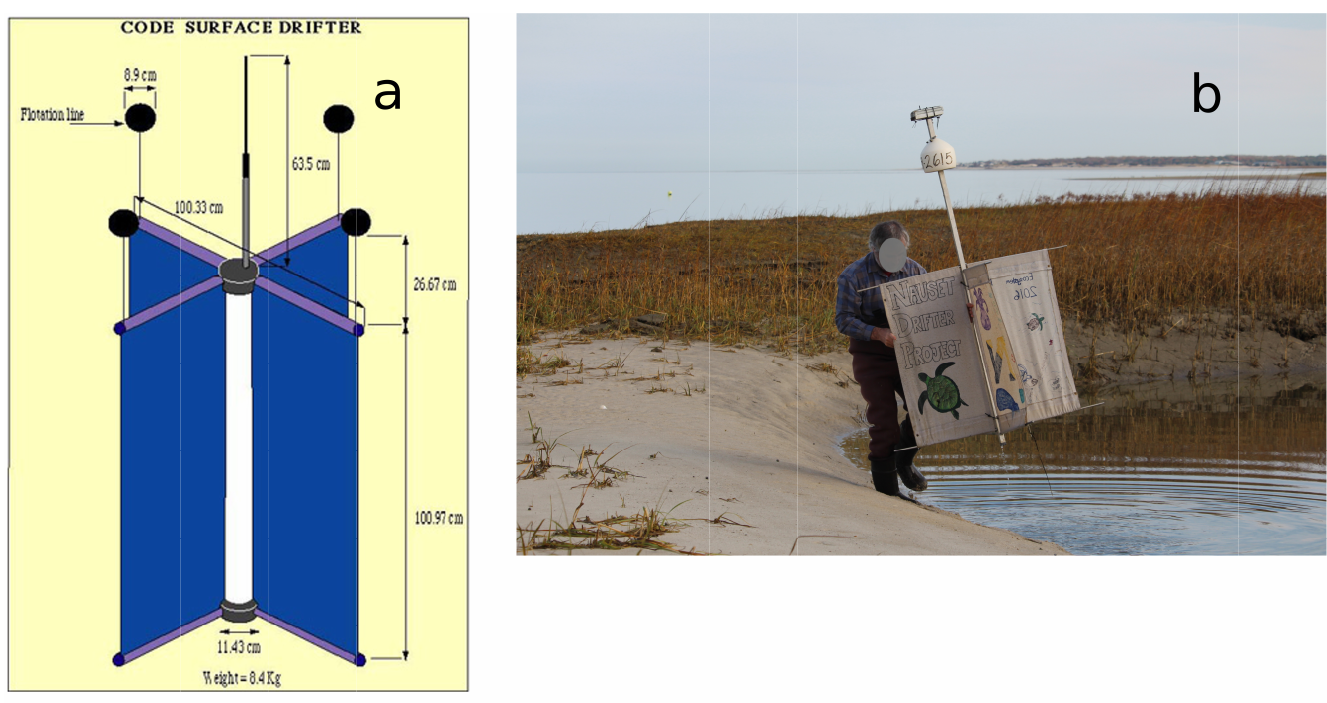
Fig 1. Schematic of standard surface drifter from Poulain [34] (left) and photo of surface drifter used in this report being recovered after stranding in Barnstable MA (right).